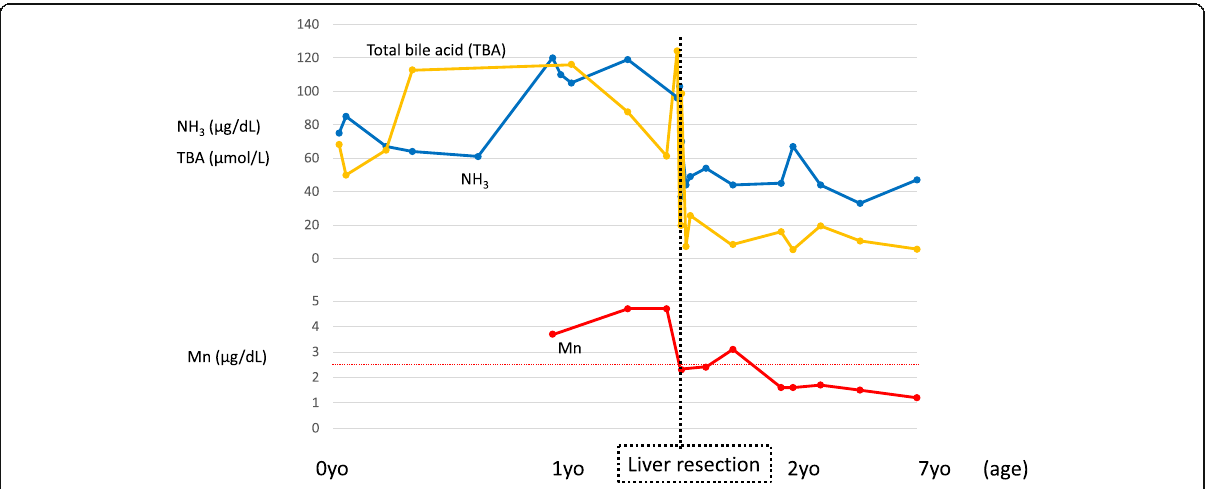
Fig. 4 Changes in laboratory data. Upper panel showing changes in ammonia and total bile acid levels. Lower panel showing changes in manganese